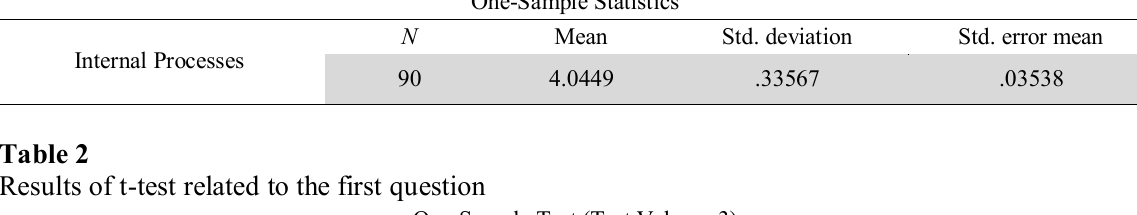
Results of descriptive statistics related to the internal processes